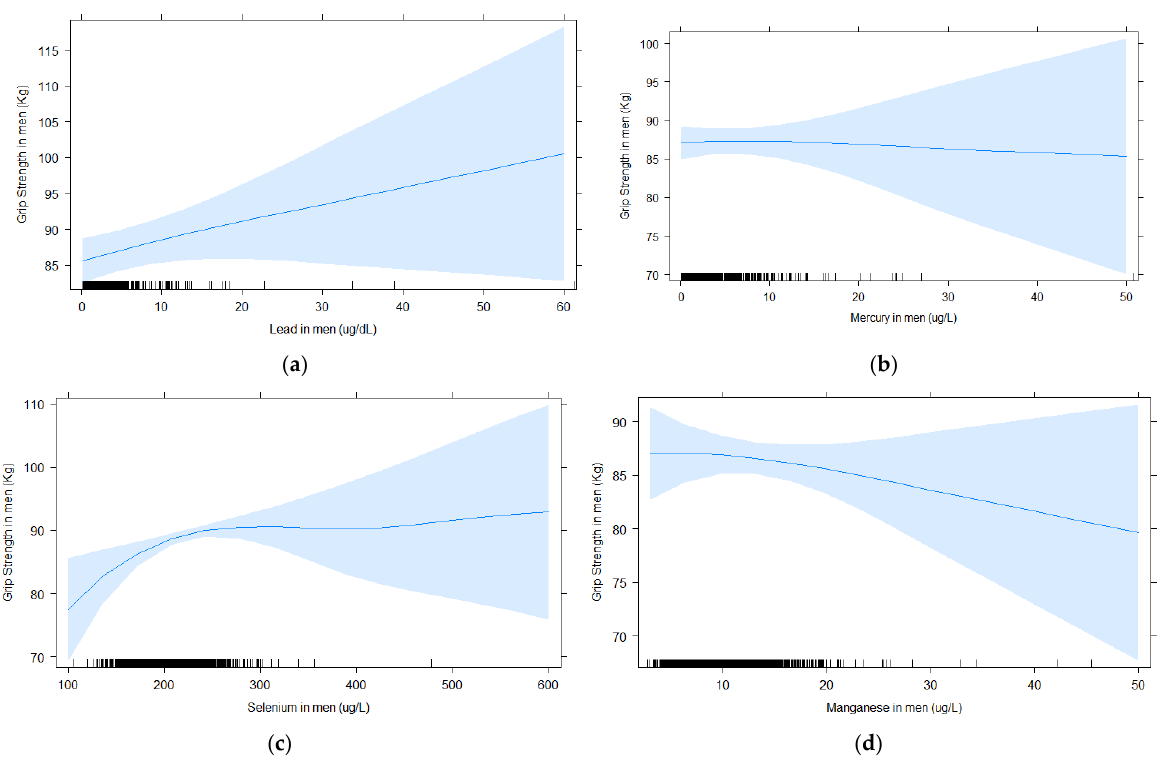
Figure 2. For men, associations between blood element concentrations and grip strength analyzed with splines (5 knots) for ( a ) lead, ( b ) mercury, ( c ) selenium, and ( d ) manganese. All models were adjusted for age, BMI, education, race/ethnicity, income to poverty ratio, smoking, and alcohol consumption.